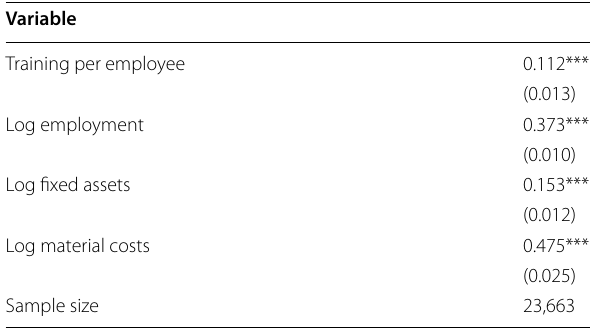
Table 6 The effect of investment in training per employee (TI) on firm productivity. Production function estimates. Method: Levinsohn and Petrin.